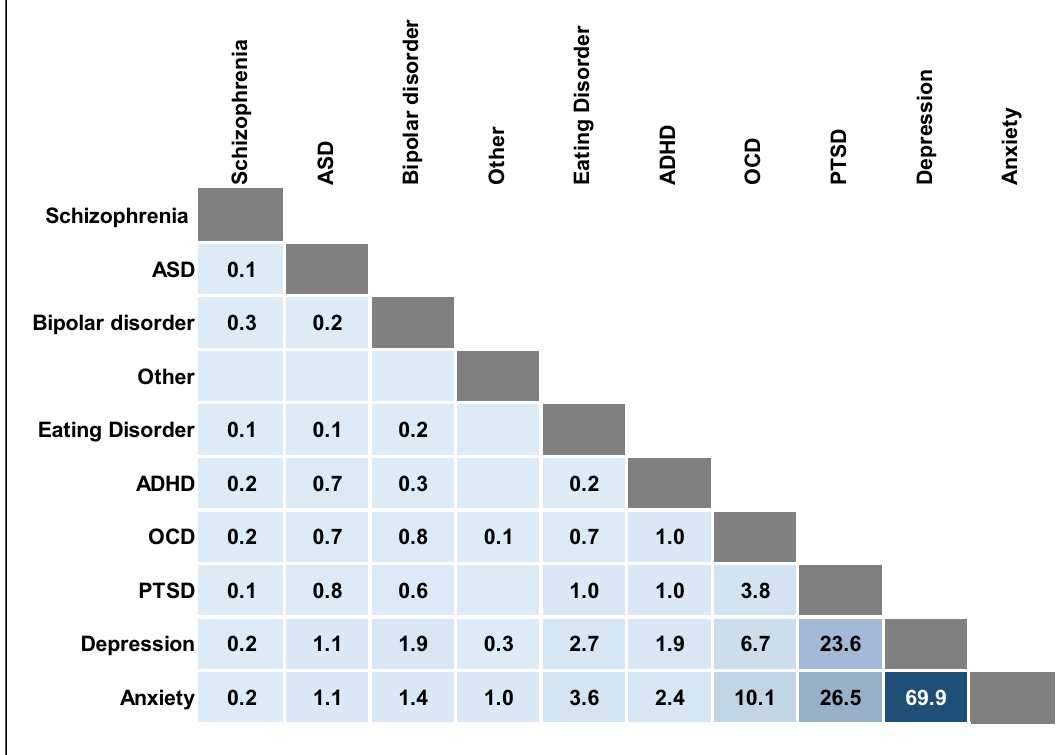
Figure 2. Firefighters’ Co-occurring Mental Health Conditions. Proportion of firefighters with more than one mental health condition (n = 878), who reported the co-occurrence of specific mental health conditions. Blank cells indicate that mental health conditions did not co-occur among surveyed